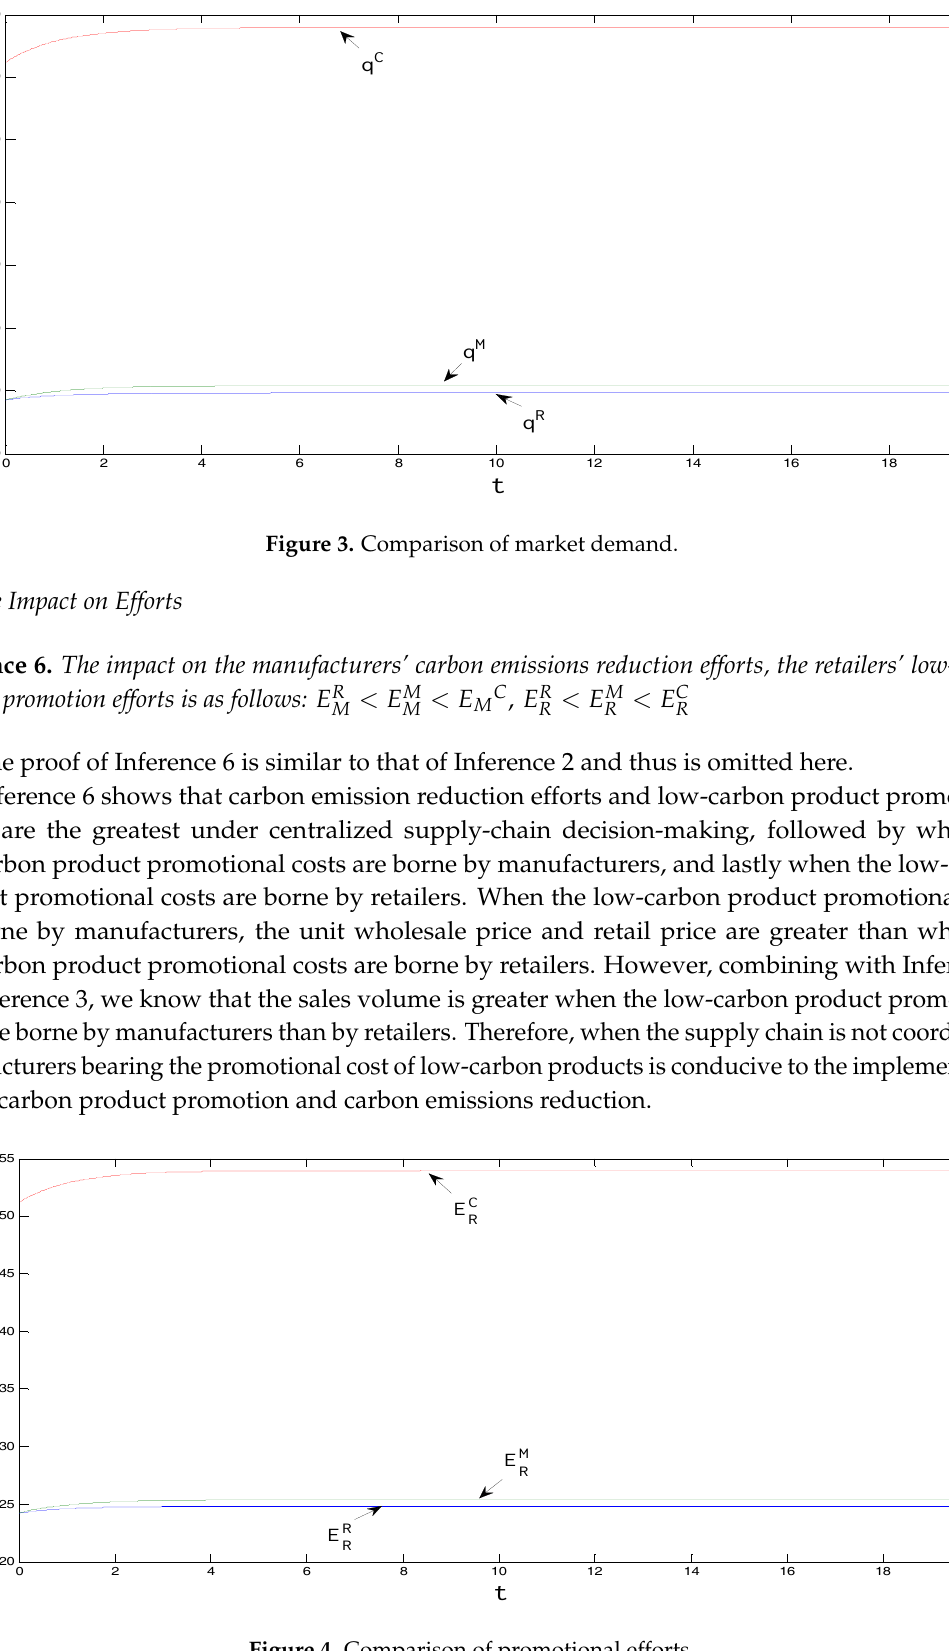
Figure 2. Comparison of retail prices.